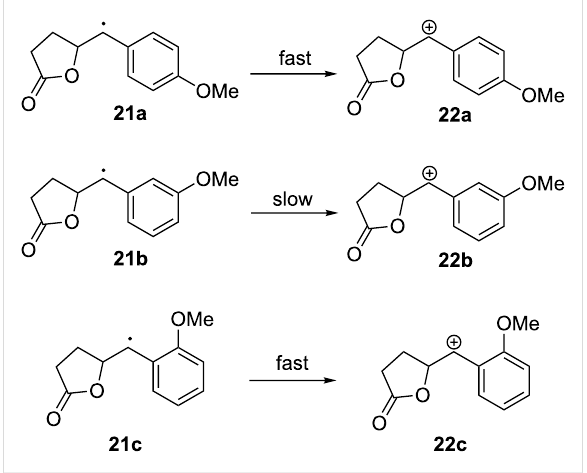
Scheme 5: Predicted relative rates of single-electron oxidation based on resonance stabilization of the resulting cation.